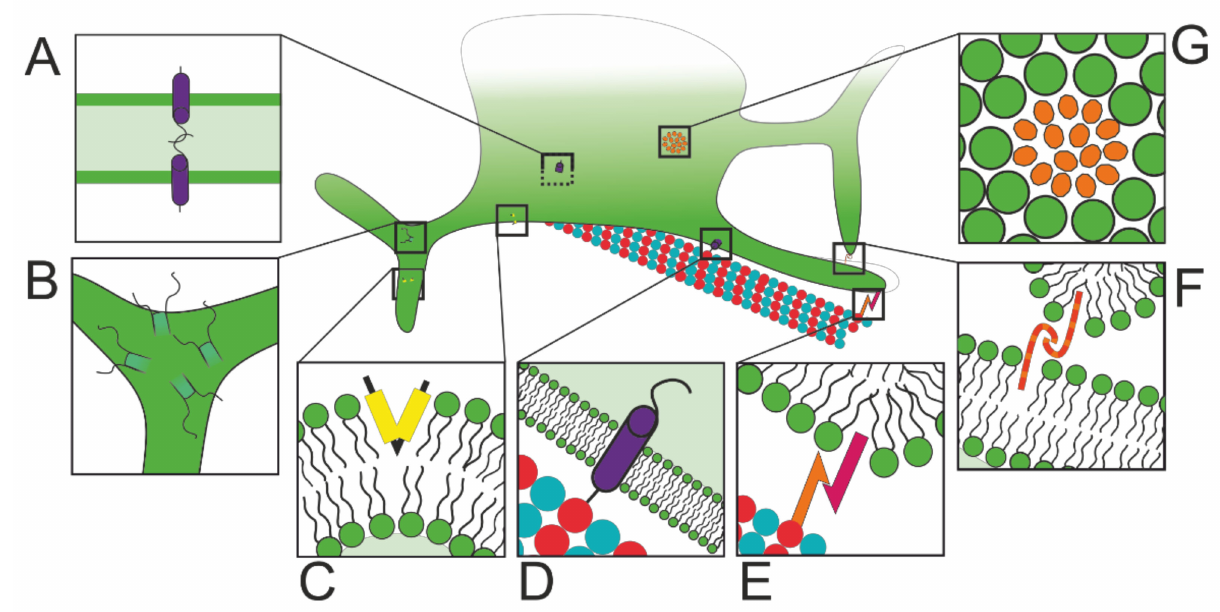
Figure 1. Diagram showing the possible mechanisms of action of ER morphology-regulating proteins. ( A ) CLIMP-63, a transmembrane ER protein, may regulate sheet thickness by forming a dimer, linking the two bilayers of an ER sheet. ( B ) Lunapark locates to and stabilises three-way junctions in the ER network, although how this is achieved is not yet known. ( C ) Proteins promoting membrane curvature, such as the reticulon and REEP families, are shaped like hairpins and localise to tubules and sheet edges (regions of high membrane curvature). The proteins are embedded in the outer leaflet of the bilayer, with the wider end at the surface, inducing membrane curvature. ( D ) Static interactions between the ER and microtubules may be facilitated by CLIMP-63, p180, REEP1, and Sec61 β . These proteins are all resident in the ER membrane and possess microtubule-binding domains. ( E ) Tip attachment complexes (TACs) are formed by interactions between the ER-resident protein STIM1 (pink) and the microtubule plus-end tracking protein EB1 (orange). ( F ) New tubules are fused to the network by atlastin, an ER-resident GTPase, which may reside in both of the sections of ER membrane to be fused. A dimer may be formed between the two proteins, promoting tubule fusion. Rab10, Rab18, and Drp1 may also promote tubule fusion, although the mechanisms are currently unknown. ( G ) Polyribosomes, groups of ribosomes gathered on the surfaces of ER sheet membranes, may maintain sheet flatness, although this has yet to be experimentally